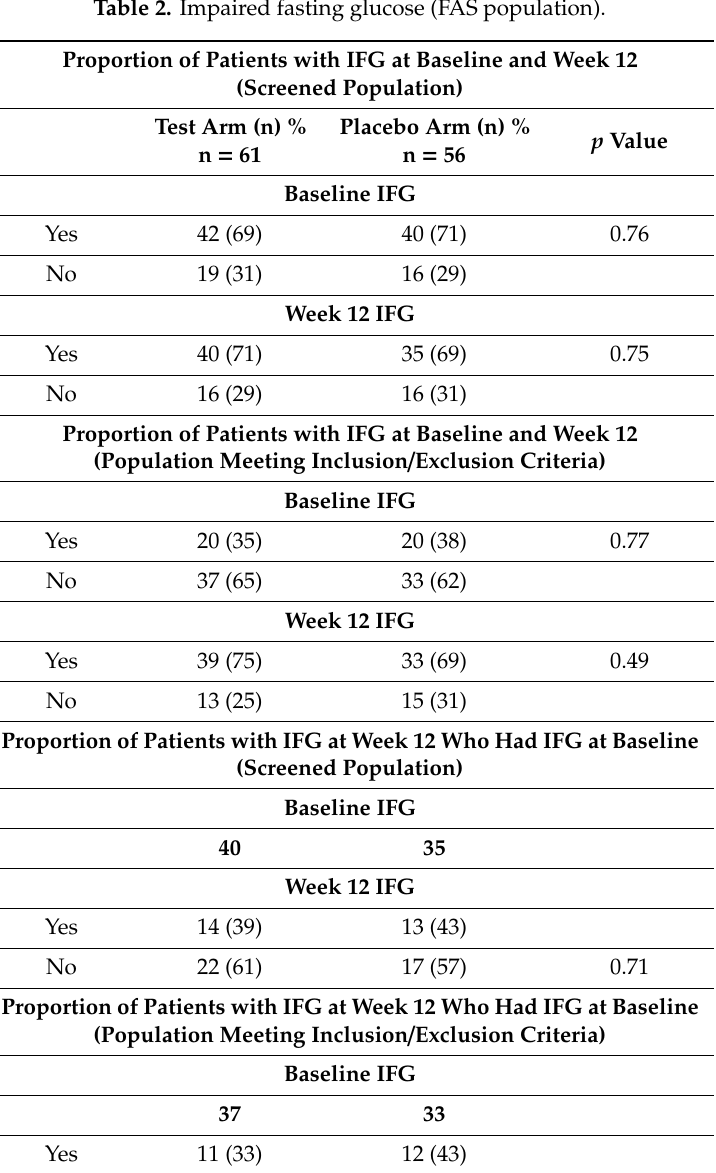
Table 2. Impaired fasting glucose (FAS